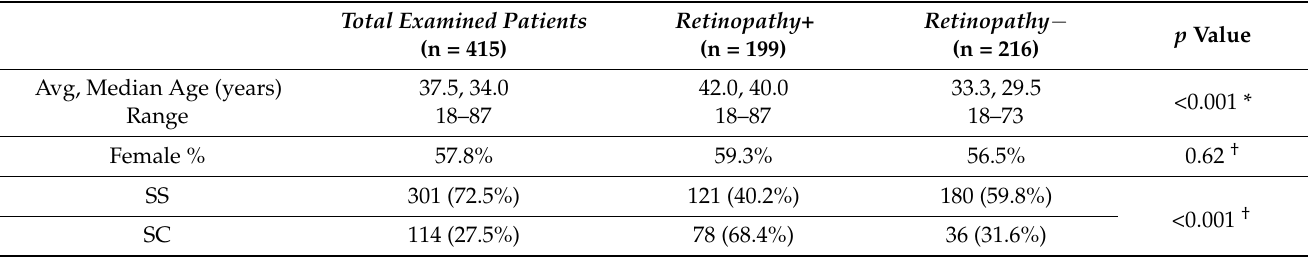
Table 1. Demographic information of patients with DFEs during the study period.